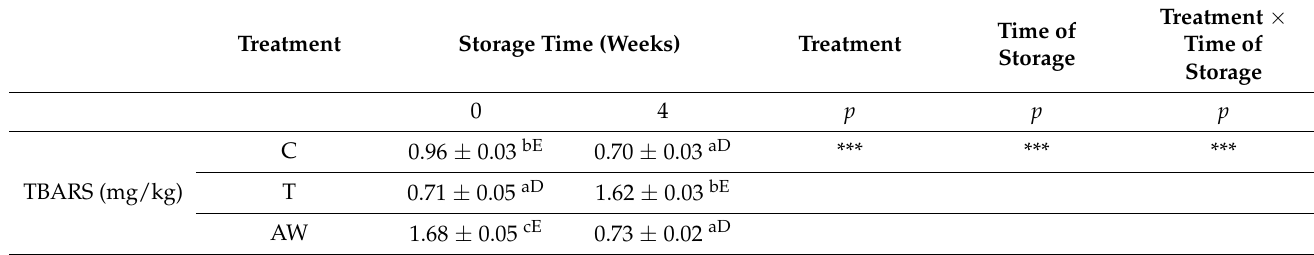
Table 4. TBARS index value of fermented pork bacon (means ± standard